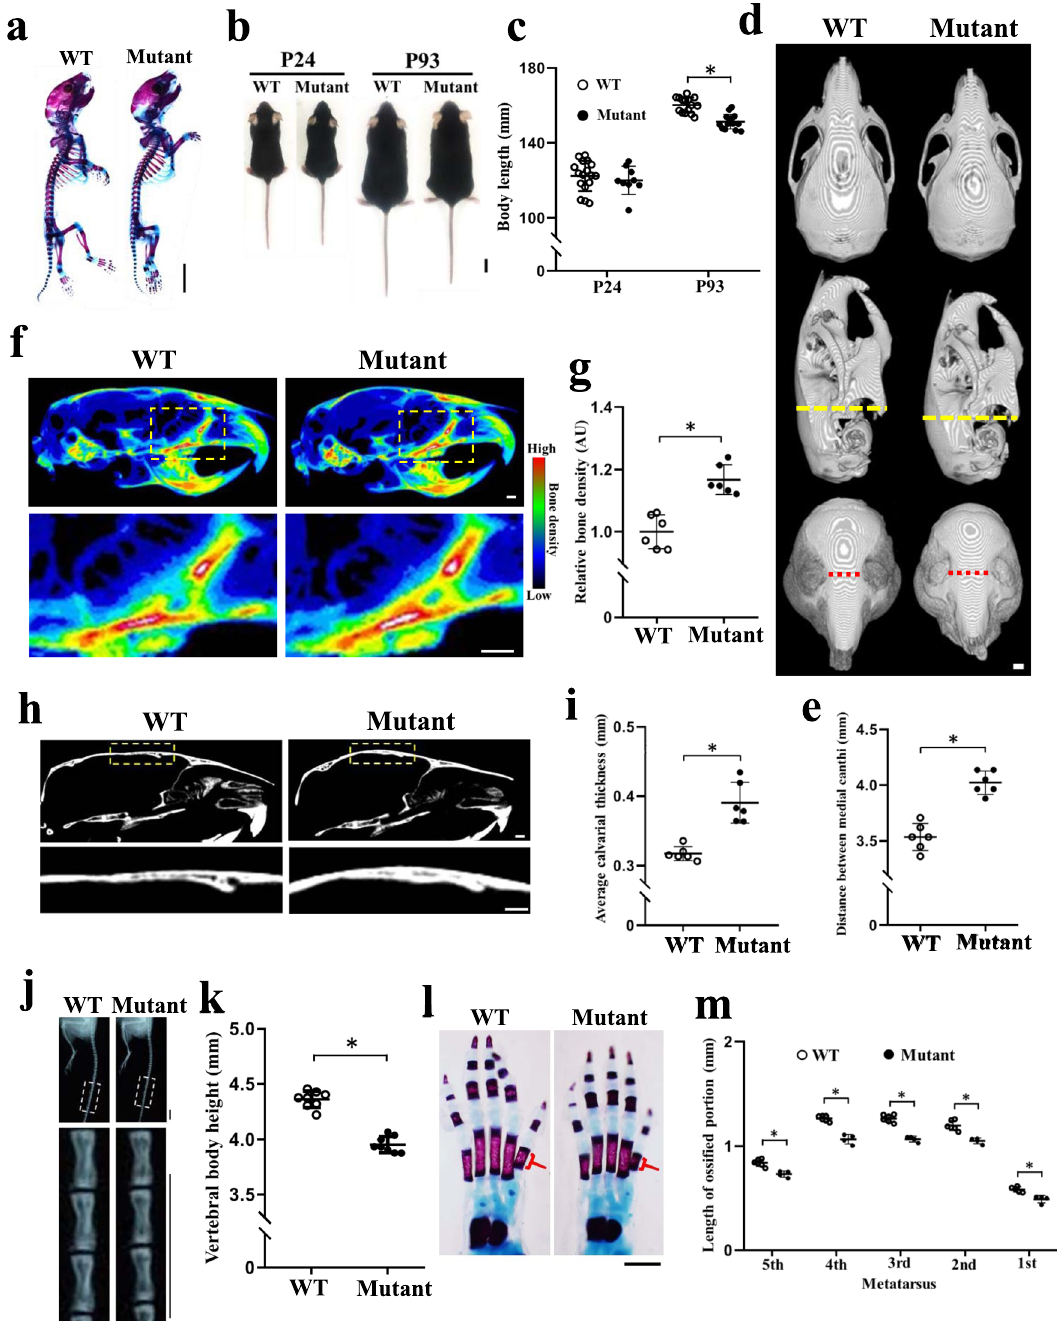
Fig. 3 Tmem53 mutant mice recapitulate the human skeletal dysplasia associated with TMEM53 pathogenic variants. a Lateral views of skeletal preparation of wild-type (WT) and Tmem53 mutant mice (Mutant) at P7. Scale bar, 5 mm. b Dorsal views of male WT and Mutant at P24 and P93. Scale bar, 1 cm. c Measurement of the body length ( n = 9, 15, 15, 17). P = 0.48 and 1 × 10 − 6 * for P24 and P93, respectively. d Representative 3D images reconstructed from micro-CT stacks of P113 mouse skull. The upper, middle, and lower panels show dorsal, lateral, and frontal views, respectively. The yellow and red dotted lines show the skull height and the distance between the medial canthi of bony orbits, respectively. Scale bar, 1 mm. e Measurement of the distance between medial canthi ( n = 6). * P = 0.000021. f Lateral views of color-coded Z-projection images of Micro-CT stacks. The areas highlighted by the dotted box in the upper panels are magni fi ed in the lower panels. Scale bar, 1 mm. g Quanti fi cation of relative bone density of the skull bases ( n = 6). AU, arbitrary unit. * P = 0.0002. h Sagittal micro-CT images of adult mice. The lower panels are the areas highlighted in the upper panels. Scale bar, 1 mm. i Quanti fi cation of the calvarial thickness ( n = 6). * P = 0.0002. j Lateral views of X-ray images of P113 mouse tails. The areas highlighted by the dotted box in the upper panels are magni fi ed in the lower panels. Scale bar, 1 cm. k Measurement of the average height of the three caudal vertebral bodies shown in j ( n = 8). * P = 0.00000003. l Skeletal preparation of left hind paws at P7. The red bracket shows the ossi fi ed portion of the fi rst metatarsus. Scale bar, 1 mm. m Quantitative analysis of the ossi fi ed portion of the metatarsal bones ( n = 4 and 6). *FDR-adjusted P = 0.0010, 0.000051, 0.000051, 0.00088, and 0.0025. The above quantitative data indicate mean ± SD and statistical signi fi cance was assessed using two-sided t -test. Source data are provided as a Source Data fi